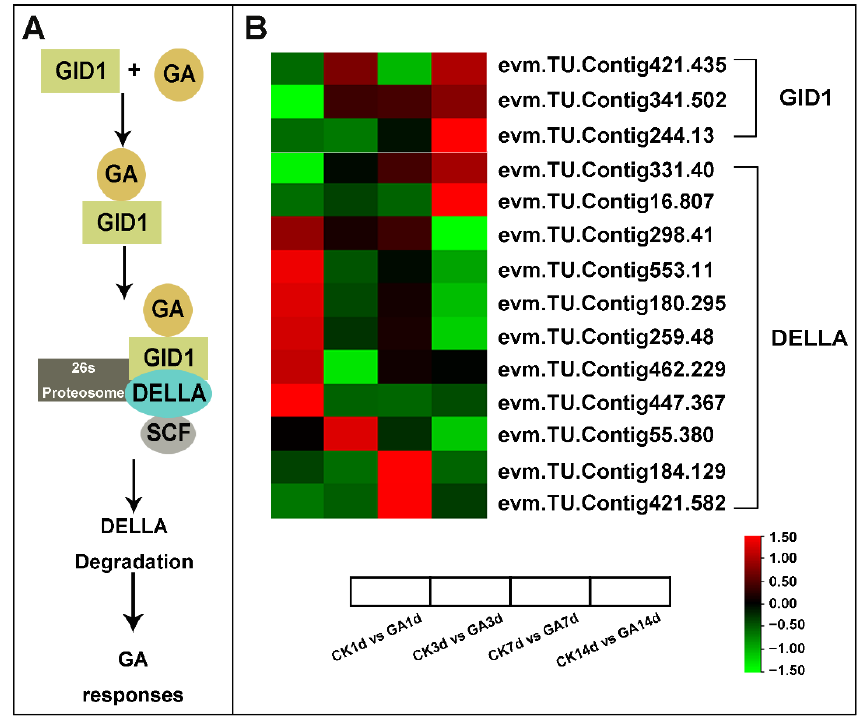
Figure 5. Simplified schematic diagram and DEGs heatmap analysis of GA signaling. ( A ) Simplified schematic diagram of the GA signaling pathway. ( B ) Heatmap analysis of GID1 and DELLA from RNA-seq data. Data is shown with log2 (Fold Change) analysis. Heatmap of columns and rows represent samples and genes, respectively.